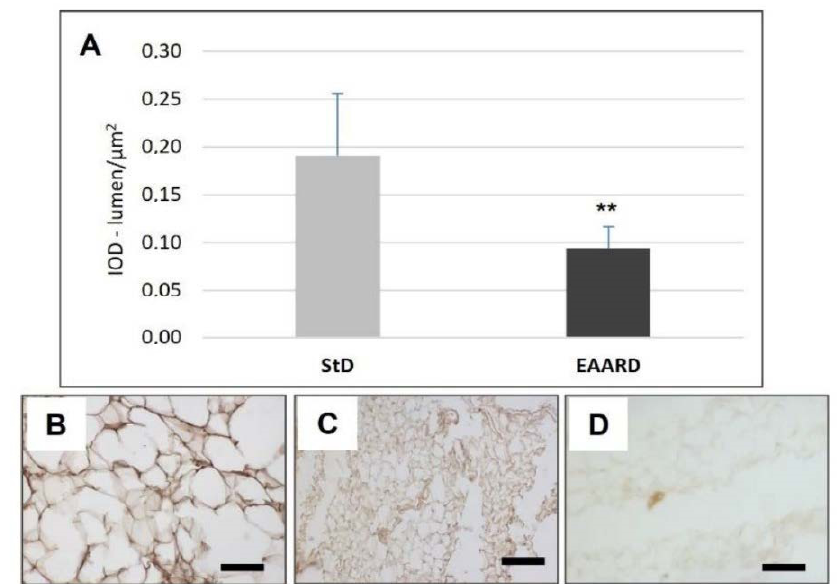
Figure 9. ( A ): Optical density for ATGL immunostaining in rpWAT ( t = 3.998, p = 0.000) according to diets (mean ± sd). ** p < 0.01. ( B , C ): Representative images of rpWAT IHC in StD and EAARD-fed mice, respectively. ( D ): Negative control performed by omitting the primary antibody. Original magnification 20 × ; scale bar 50 µ m.